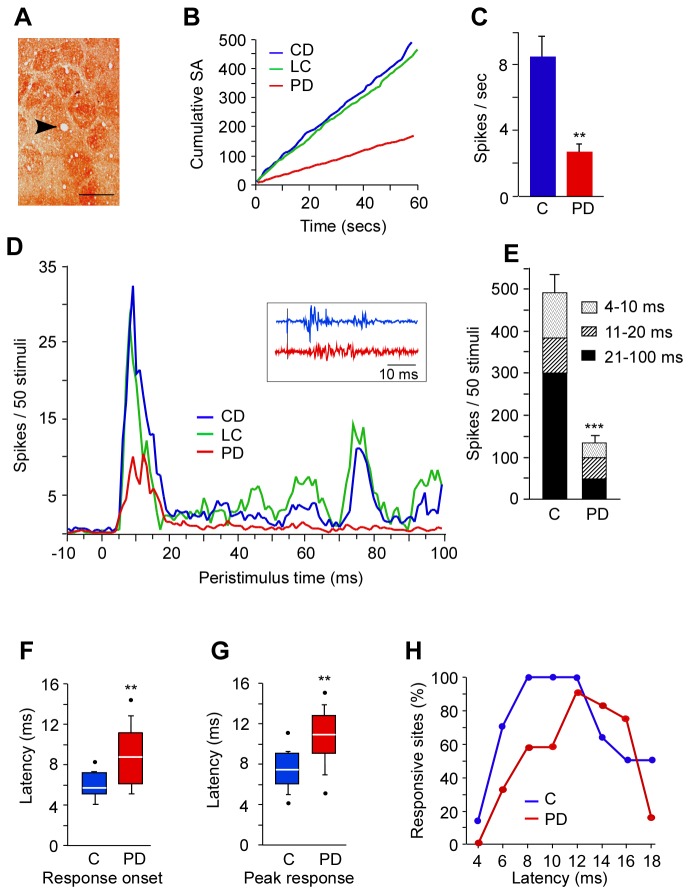
Activity of L4 barrel neurons in PD and control animals.
A, Image of a tangential section through the barrel cortex of PD rat, arrowhead shows the recorded site in the D3 barrel marked with a lesion, scale bar = 500 µm. B, Cumulative multiunit spontaneous activity (SA; spikes/s) over a 1 minute epoch from PD, CD and LC rats. C, Spontaneous discharge rate shown as average number of spikes generated per second (± SEM) of L4 neurons from PD and control (‘C’: CD and LC combined) rats. D, Population peristimulus-time histograms of L4 multiunits from PD, LC and CD rats. Stimulus onset is at 0. Note the small initial response and severely depressed long latency response in PD rats (red line). Inset: Representative waveforms recorded from L4 neurons from a site in PD and control rat barrel cortex. Stimulus onset indicated by the grey vertical line across both waveforms. E, Total response magnitude, showing three pattern-coded latency epochs, is greatly reduced in PD rats compared to controls (‘C’: mean value ± SEM from LC and CD combined). F, Response onset latency, G, peak response latency, and H, number of responsive sites (%) at different latencies emphasize the delay in response of L4 neurons in PD rats compared to controls (‘C’: mean value ± SEM from LC and CD combined). For details see ‘Methods’ and ‘Results’. ** p ≤ 0.01, *** p ≤ 0.001. PD: protein-deficient diet fed rats, CD: control diet fed rats; LC: laboratory chow fed rats. Note: As there is no statistical difference between the data from CD and LC groups, the data from both groups were combined as a single control group in C, E, F, G and H.